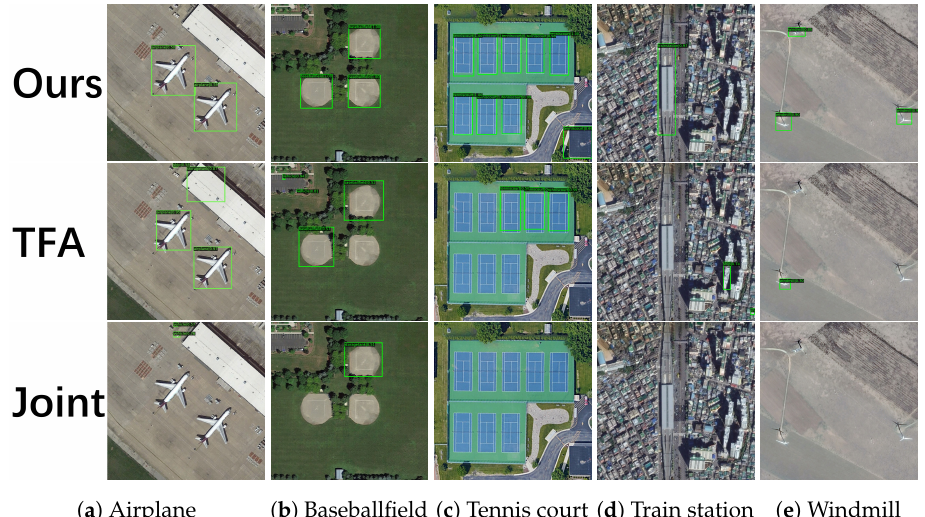
Figure 12. Results of 20-shot models on novel classes in the DIOR dataset. (From top to bottom: Ours, TFA and